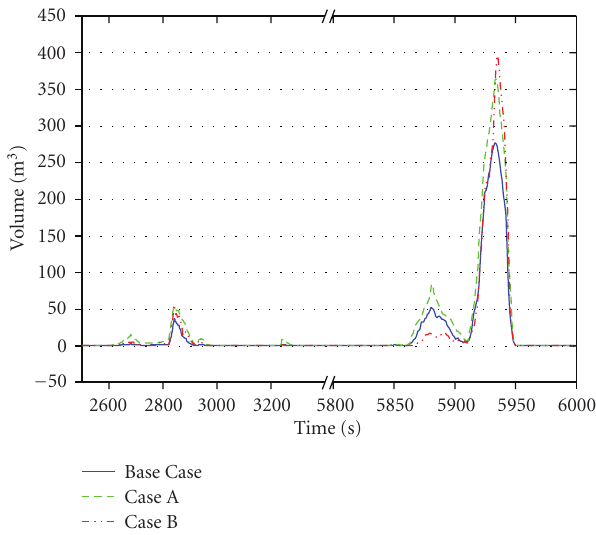
Figure 12: Total volume of sigma clouds.